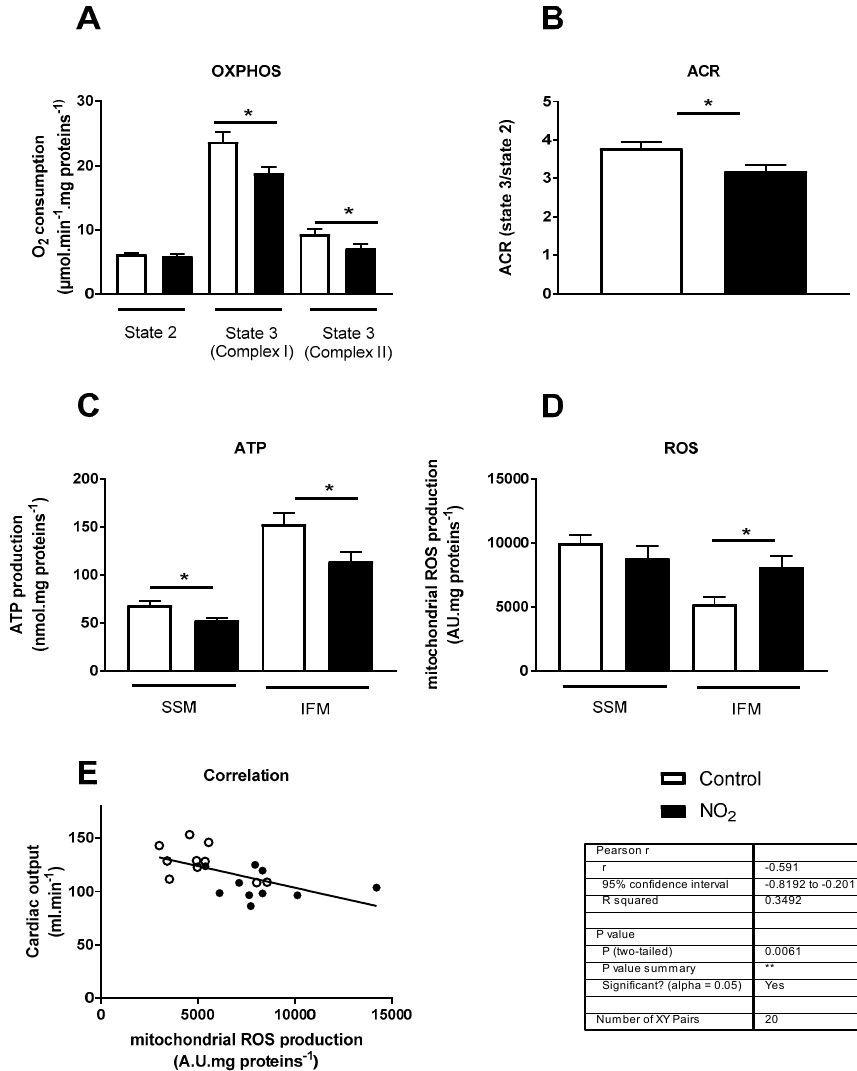
Figure 7. Cardiac mitochondrial function, ROS production and correlation with cardiac function, at 1-day post-exposure after repeated NO 2 exposures. ( A ) Mitochondrial OXPHOS evaluated by O 2 oxygen consumption assessment in permeabilized fibers. State 2 respiration with complex I-linked substrates (Glutamate/Malate); State 3 respiration with ADP and complex I-linked substrates (Glutamate/Malate); State 3 respiration with ADP and complex II-linked substrates (Succinate); ( B ) ACR with complex I-linked substrates ( C ) ATP (nmol/mg proteins) and ( D ) ROS productions (A.U/mg proteins) were measured from freshly isolated SSM and IFM. ( E ) Correlation between cardiac output and interfibrillar mitochondrial ROS production. * p < 0.05.